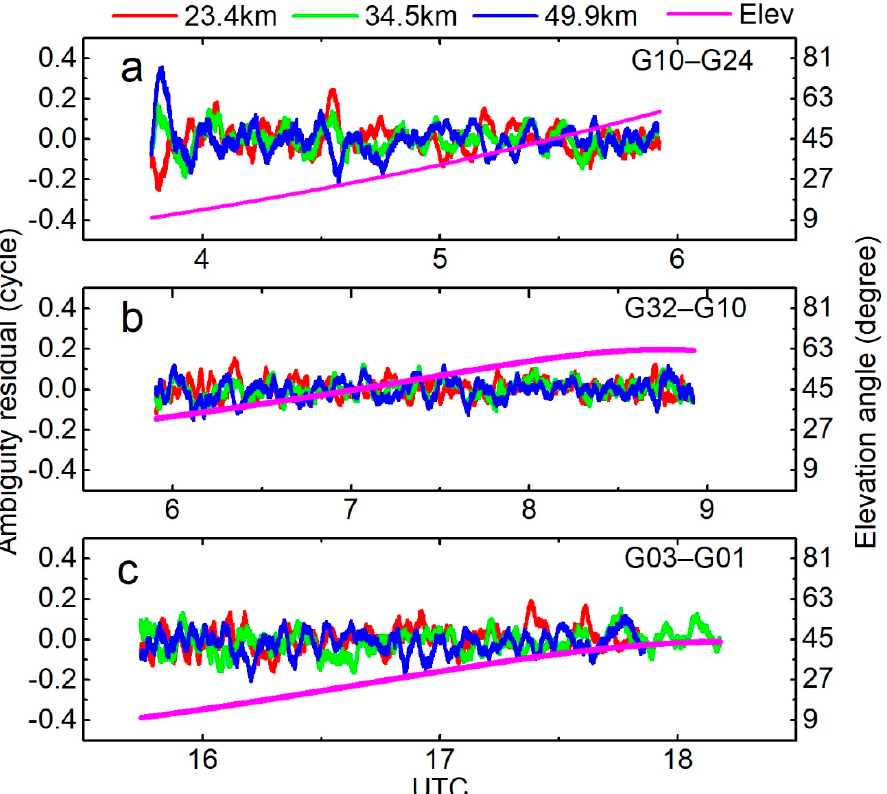
Figure 7. The optimal EWL ambiguity residual by the HMW combination with L2 and L5, as well as the corresponding satellite elevation angle in the single-epoch mode ( a ): G10–G24; ( b ): G32–G10; ( c ): G03–G01).